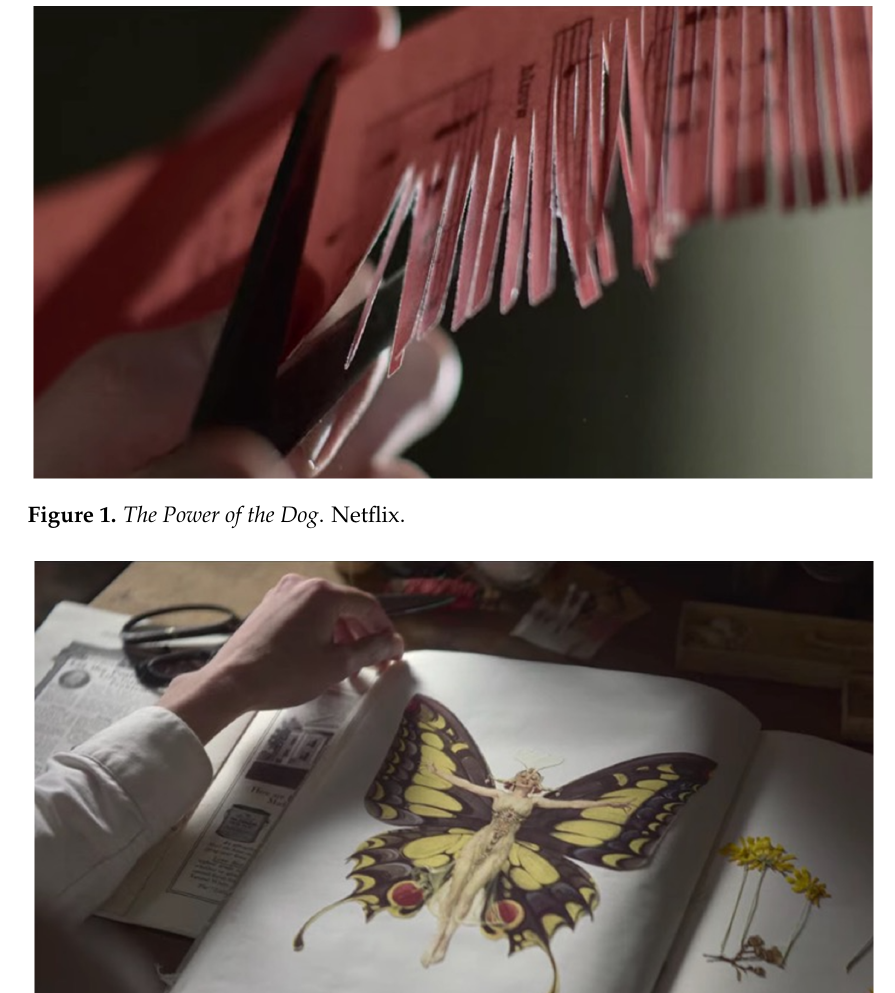
Figure 1. The Power of the Dog . Netflix.